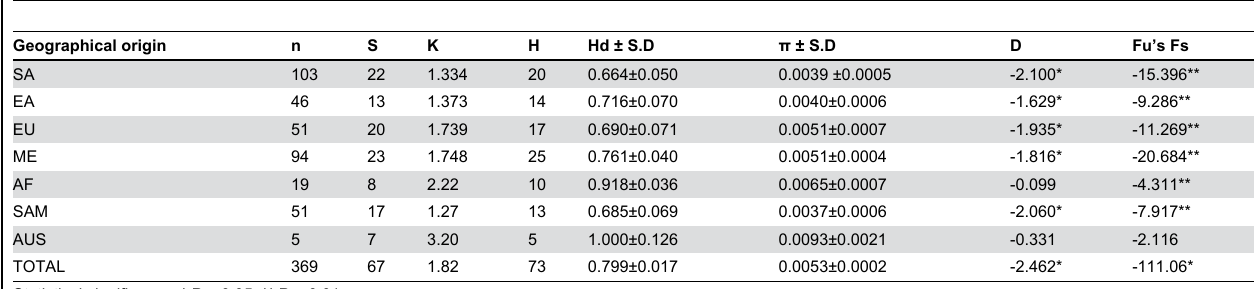
Table 2. Diversity and neutrality indices of Echinococcus granulosus sensu stricto population calculated from nucleotide sequence of mitochondrial cox1